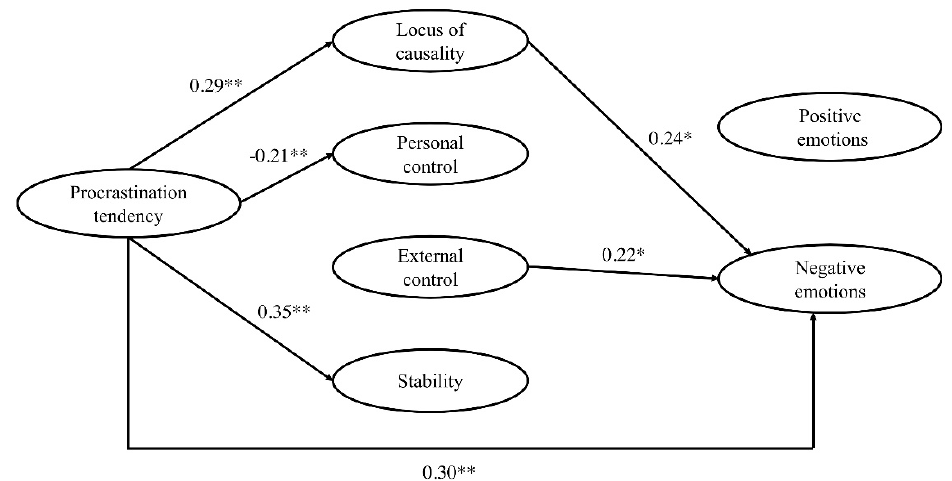
Figure 2. Structural equation model of hypothesized relations between procrastination tendency, attributions, and emotions; standardized estimates are displayed; * p < 0.05, ** p < 0.001.